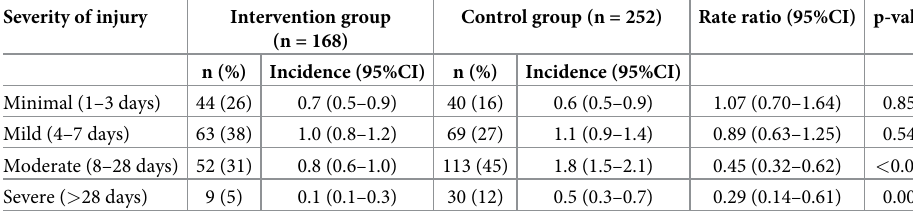
Table 4. Effectiveness of the intervention on the severity of